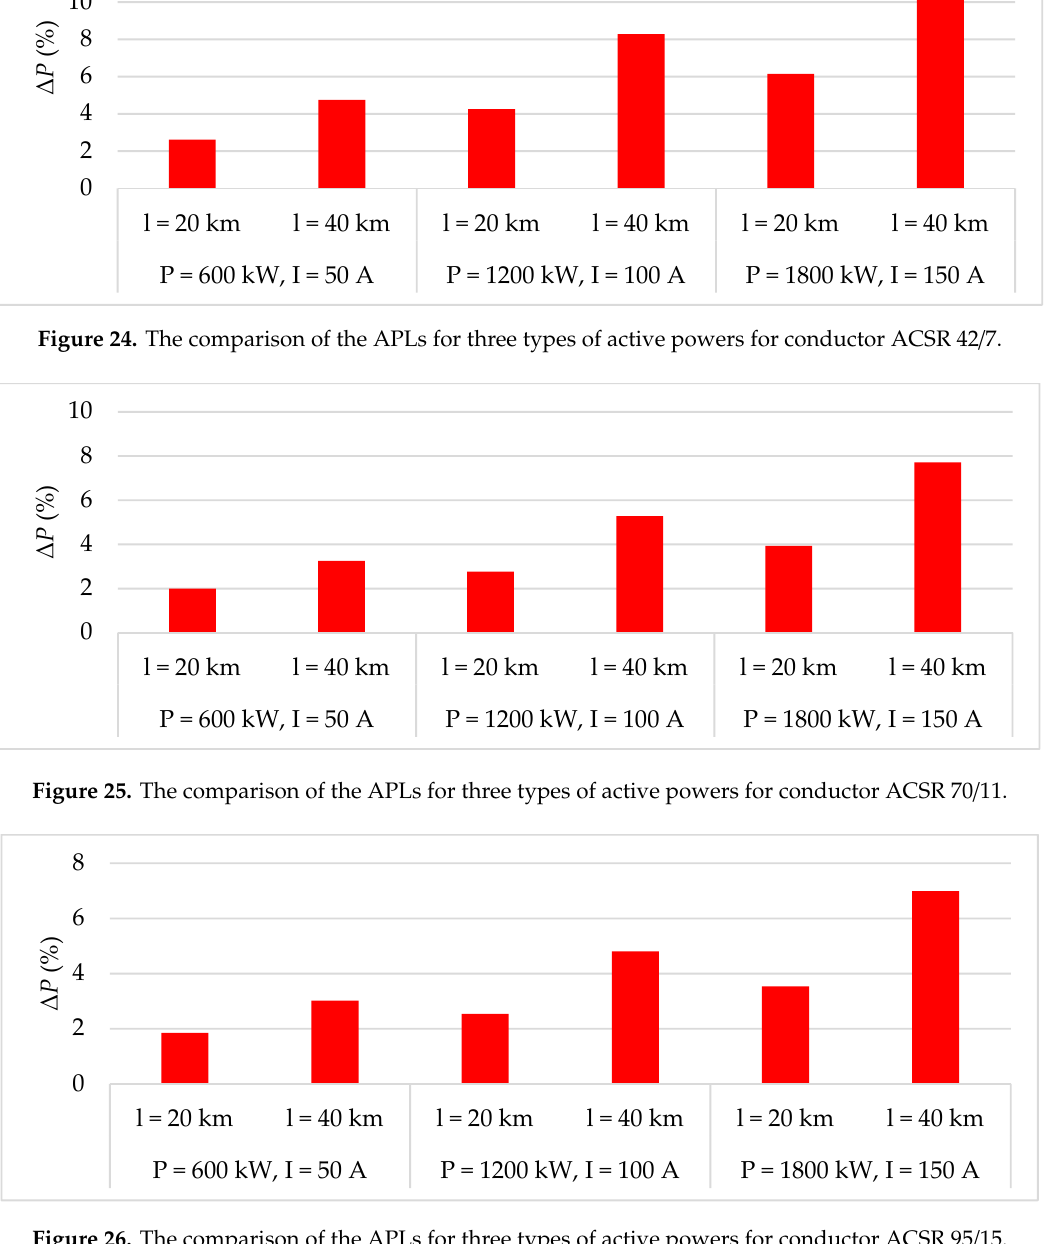
Figure 27. The scheme of measured and modelled distribution grid. ( a ) ( b ) Figure 28. The voltages (full line) and the currents (chain line): ( a ) the measurement; ( b ) the simulation.